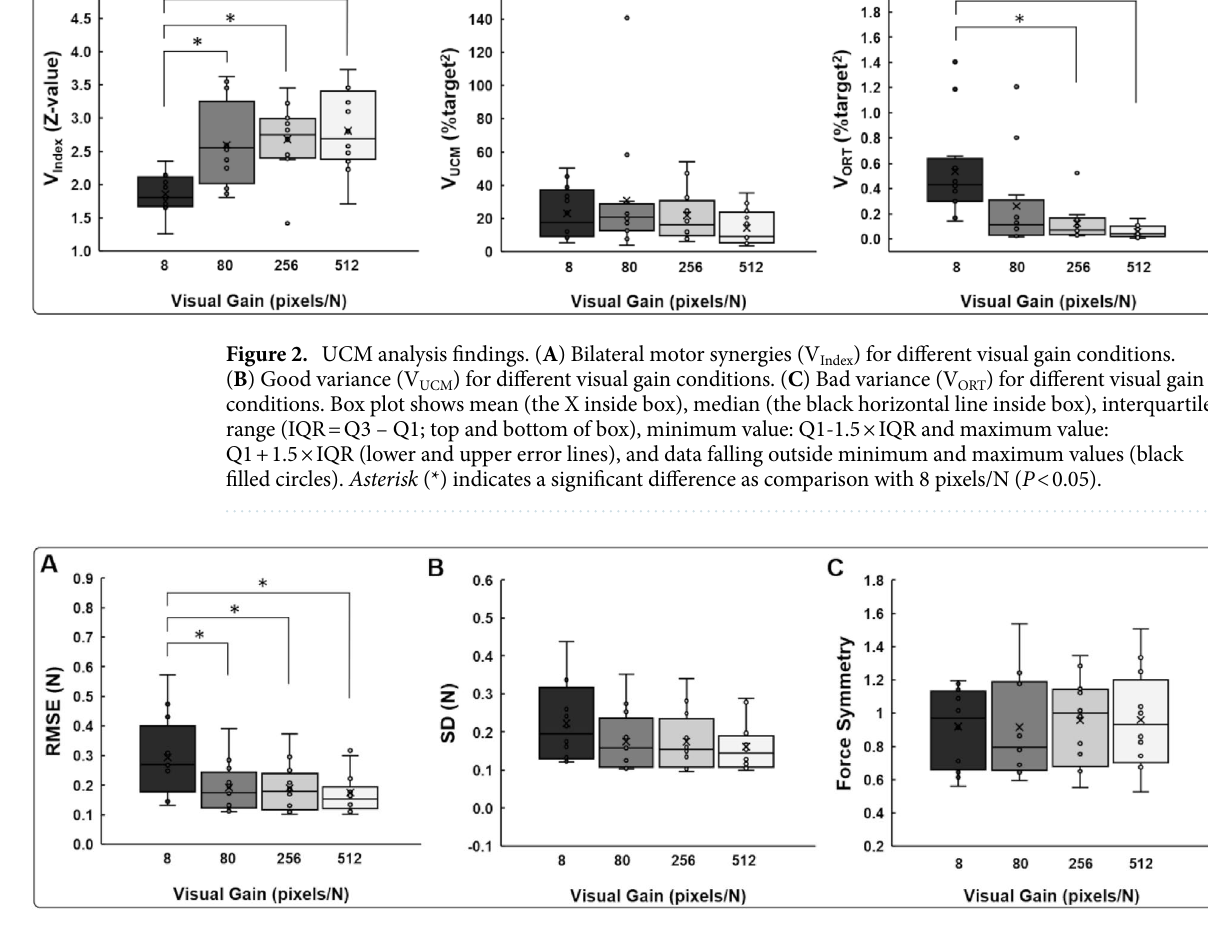
Figure 3. Bimanual Force control findings. ( A ) Force accuracy (RMSE) for different visual gain conditions. ( B ) Force variability (SD) for different visual gain conditions. (C ) Force symmetry for different visual gain conditions. Box plot shows mean (the X inside box), median (the black horizontal line inside box), interquartile range (IQR = Q3 – Q1; top and bottom of box), minimum value: Q1-1.5 × IQR and maximum value: Q1 + 1.5 × IQR (lower and upper error lines), and data falling outside minimum and maximum values (black filled circles). Asterisk (*) indicates a significant difference as compared with 8 pixels/N ( P <